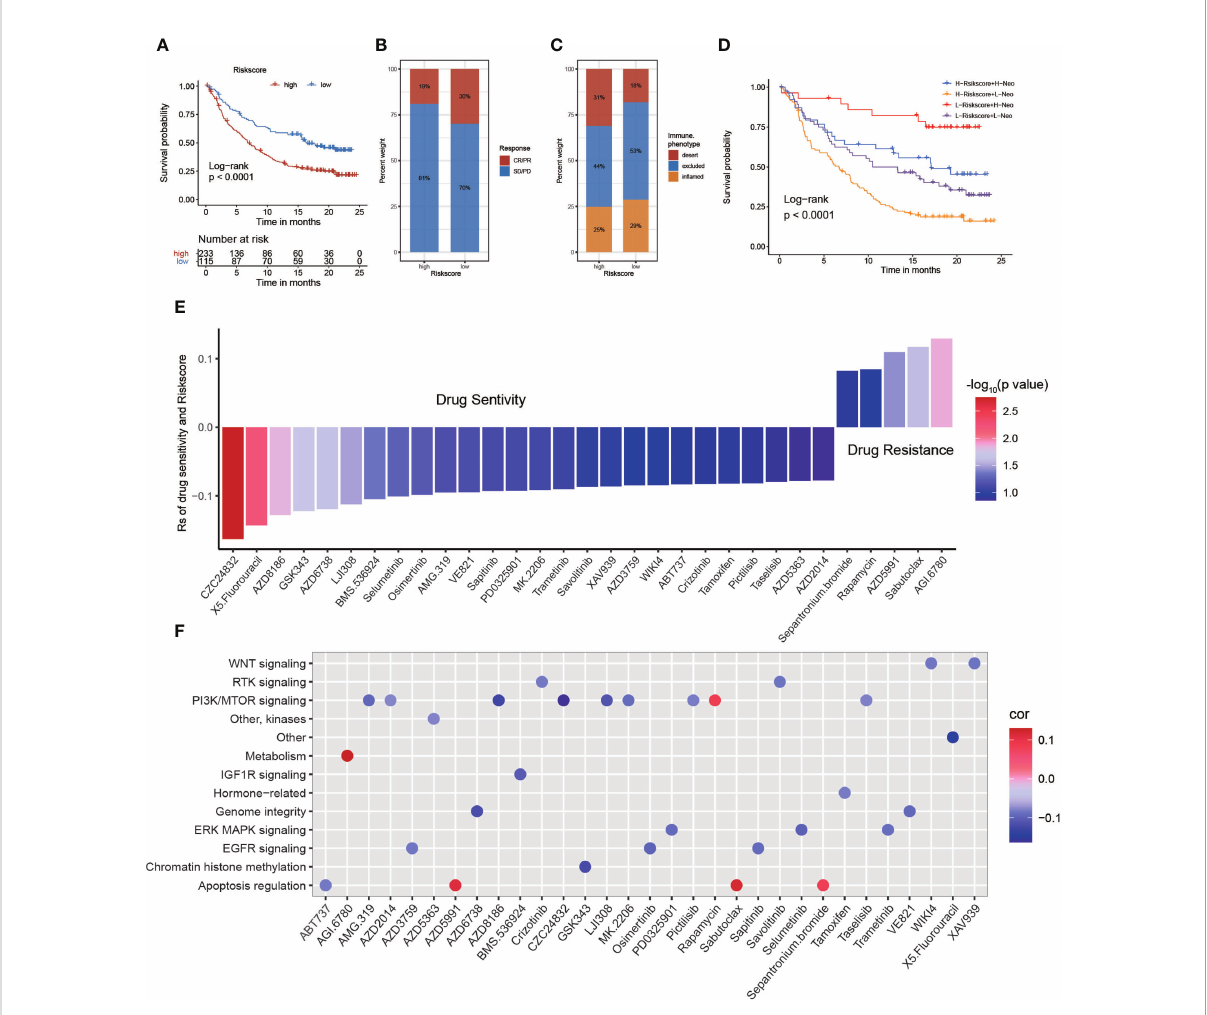
FIGURE 8 The relationship between risk score and response to immunotherapy and drug sensitivity. (A) Survival analysis of the low and high-risk score patient groups in an immune checkpoint blockade (ICB) therapy cohort. (B) The immunotherapy response and immune phenotypes of patients with GBM in high- and low-risk scores. (C, D) Survival analyses of patients with GBM receiving ICB therapy by risk score combining tumor neoantigen burden. (E) Assessing drug sensitivity of GBM tumor based on the risk score. (F) Signal paths targeted by drug sensitivity with the risk score. Blue (positive correlation) or red (negative